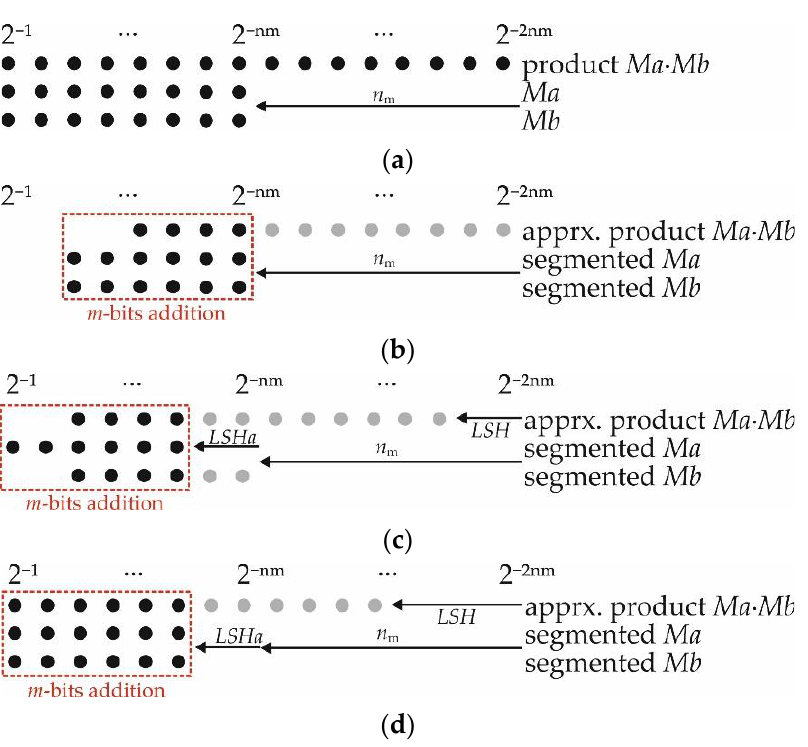
Figure 5. Segmented MAA that implements Equation (11).